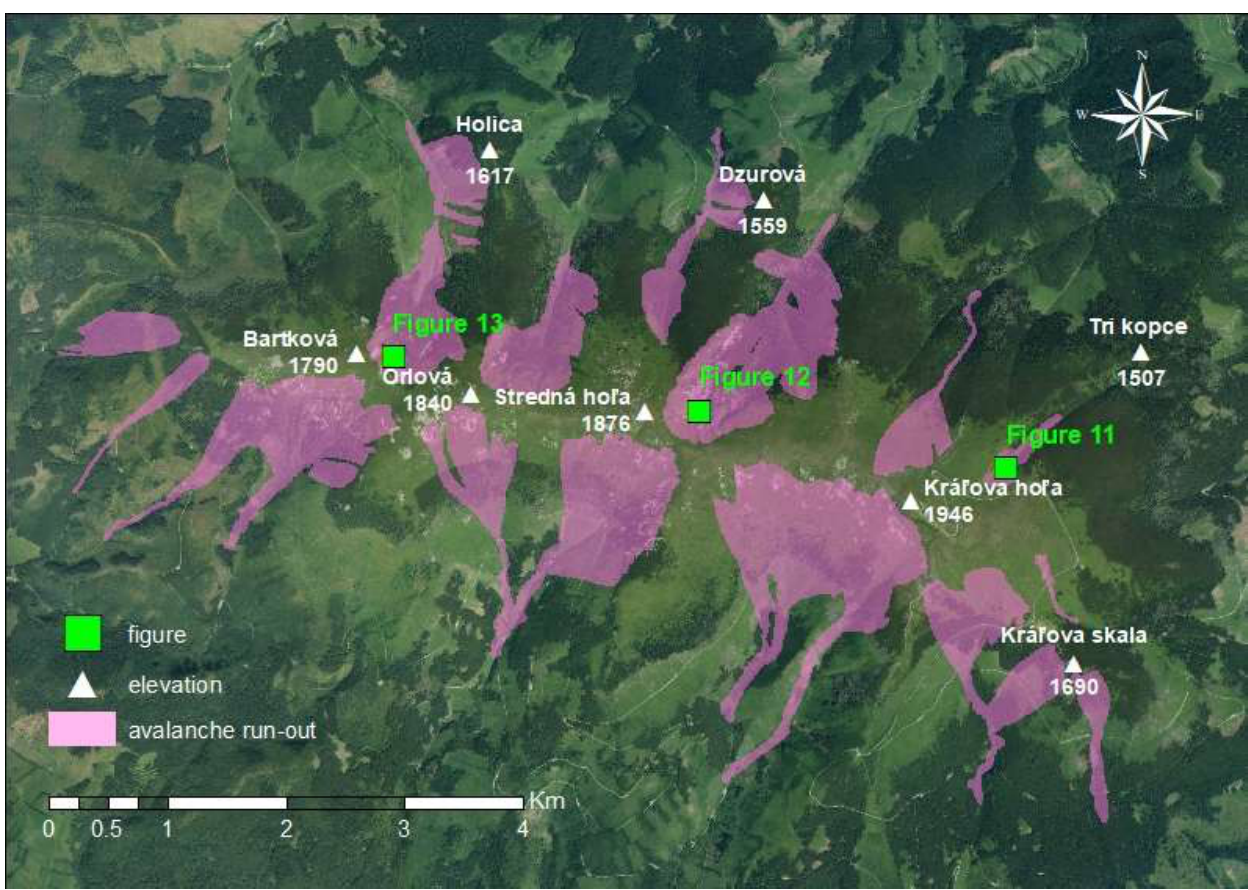
Figure 10. Layout of the avalanche cadastre based on results from the RAMMS model. Source orthophoto: The Geodesy, Cartography and Cadastre Authority of the Slovak Republic. A total of fourteen interconnected avalanche run-out areas have been identified within the studied area. There are six of them at the northern foot of the ridge and at the southern foot there are eight. The largest complex of avalanche run-outs is located on the southern slope in Šumiacka dolina. Its area exceeds 2 km 2 and it has the highest width of